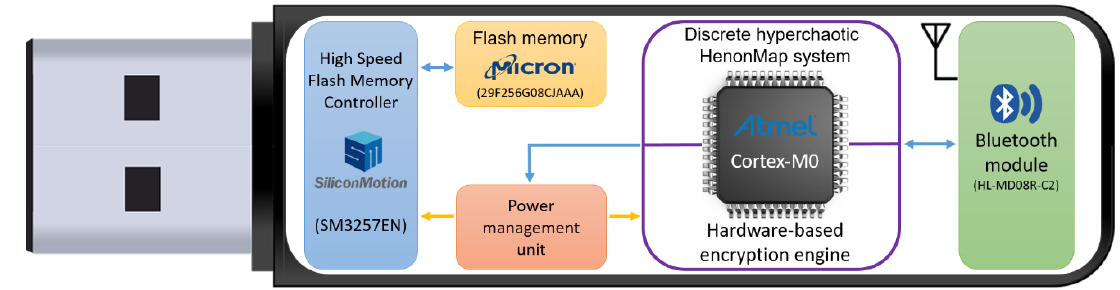
Figure 6. High-security USB flash drive architecture.